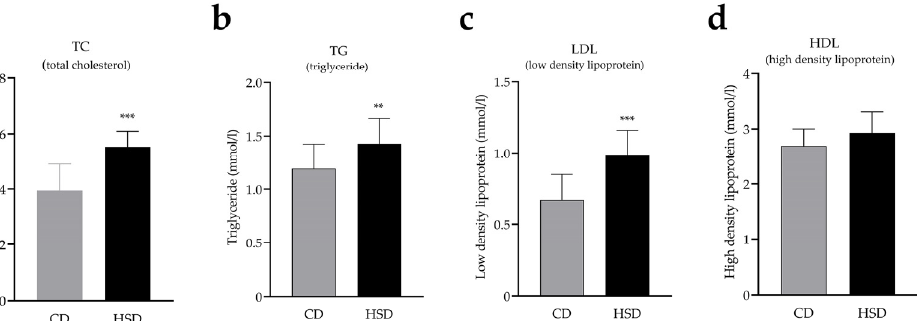
Figure 3. HSD mice have disordered lipid metabolism. ** p < 0.01, *** p < 0.001. When compared with CD group results are presented as the mean ±